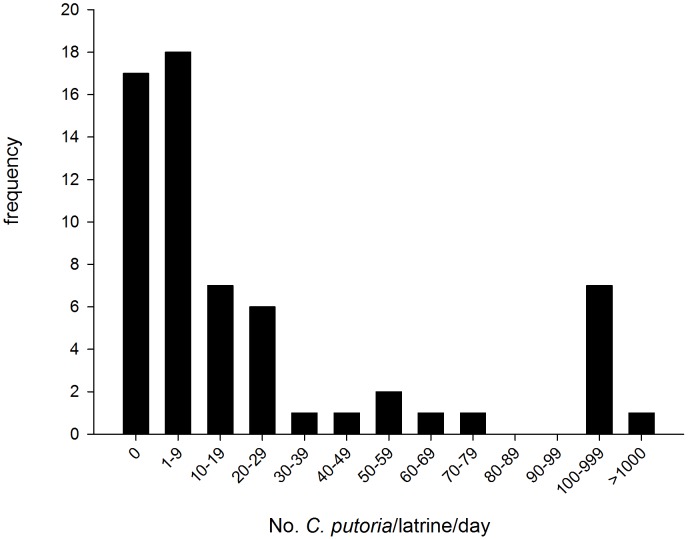
Frequency of flies collected from 62 pit latrines in the rainy season.